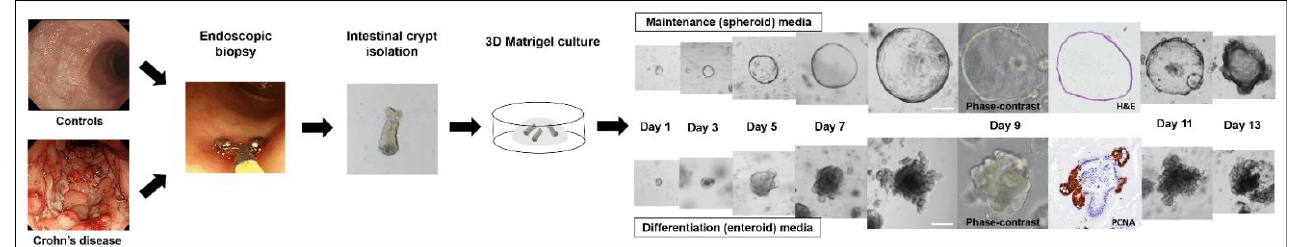
Figure 10. Flow diagram of the patient-derived intestinal organoid model. Scale bar = 100 μm.